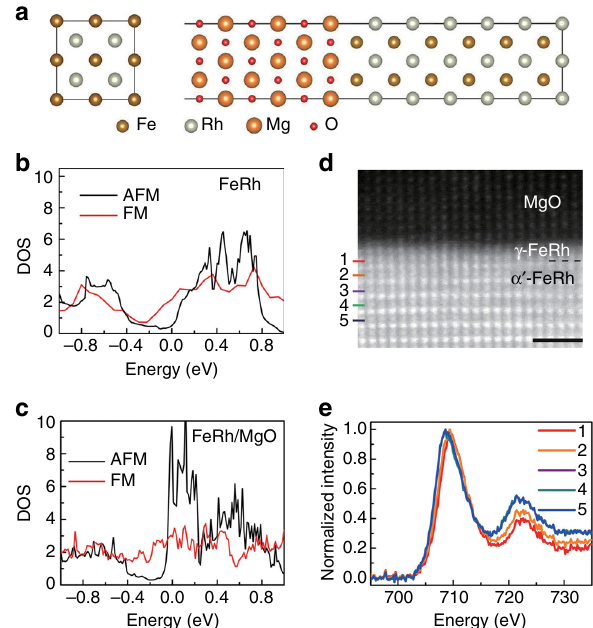
Fig. 3 Theoretical DOS of α ′ -FeRh bulk and α ′ -FeRh/MgO interface, and the interfacial characterization. a FeRh and MgO/FeRh supercell with a 20 Å thick vacuum layer were built to calculate the DOS of the bulk FeRh and the interfacial α ′ -FeRh capped with MgO, respectively. b , c Theoretical DOS of α ′ -FeRh bulk and one unit cell-scaled α ′ -FeRh in the vicinity of the α ′ -FeRh/MgO interface. d High resolution STEM Z -contrast image with one unit cell-thick γ -FeRh naturally superimposed at the α ′ -FeRh/MgO interface. Scale bar is 1 nm in length. e EELS of Fe is marked as 1 – 5 (marked in d ) in the order of increasing the distance from the interface with ~0.3 nm gap NATURE COMMUNICATIONS | 8: